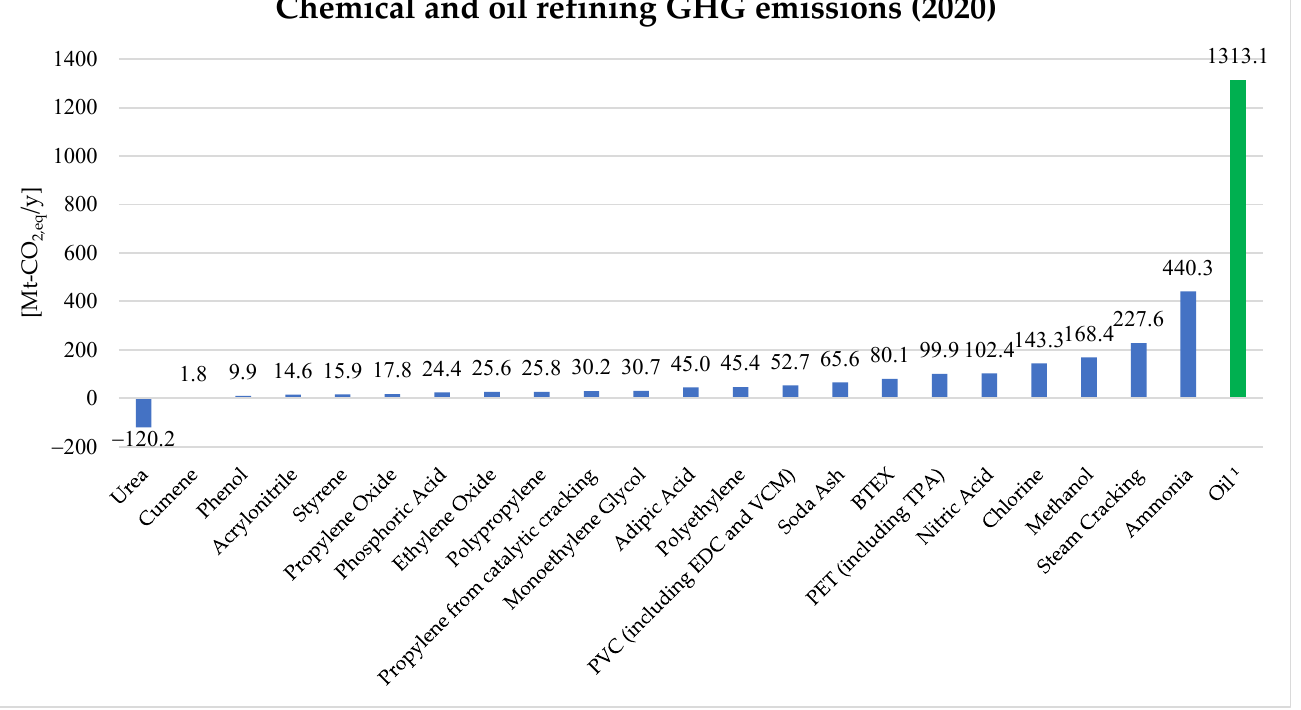
Figure 4. Annual global greenhouse gas emissions related to the main products of the chemical (in blue) and oil refining (in green) industry (2020). 1 “Oil” includes crude oil, shale oil, oil sands, condensates, and natural gas liquids. Based on the same references of Figures 2 and 3 with the addition of [10,28,48,49,52,53,55–67].